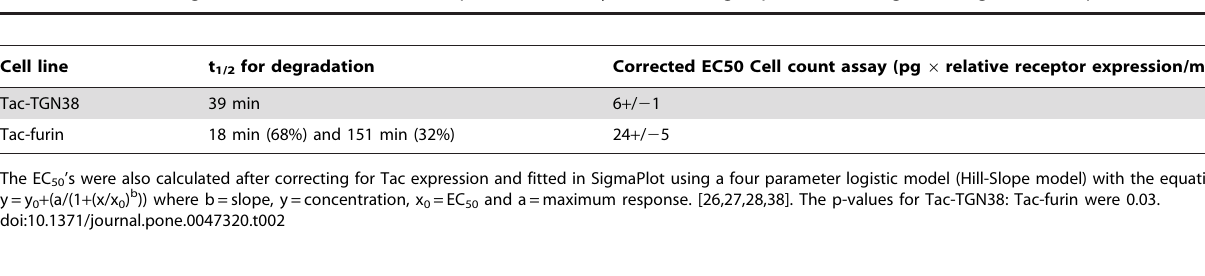
Table 2. t 1/2 for degradation were based on exponential decay curve fitting equation (see figure 5 legend for equation).